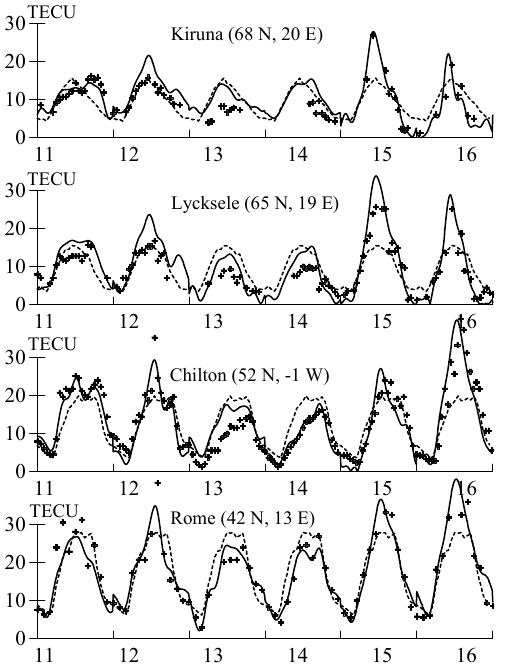
Fig. 4. Diurnal variation of TEC (solid curves), ( f o F2) 2 (crosses) and monthly median (dots) in relative scale during 11–16 Septem- ber.